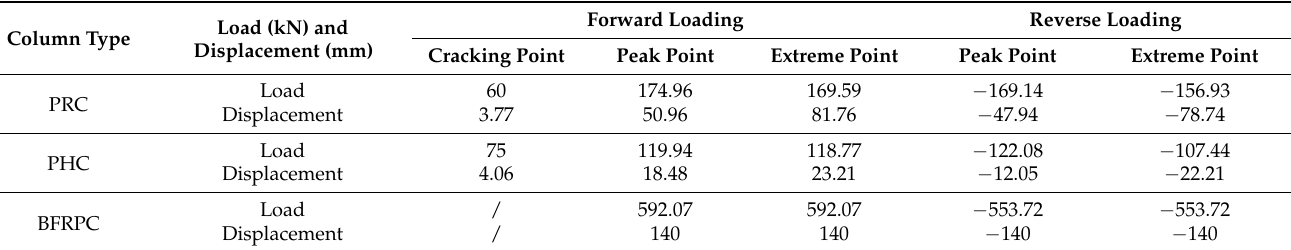
Table 3. The feature points of the skeleton